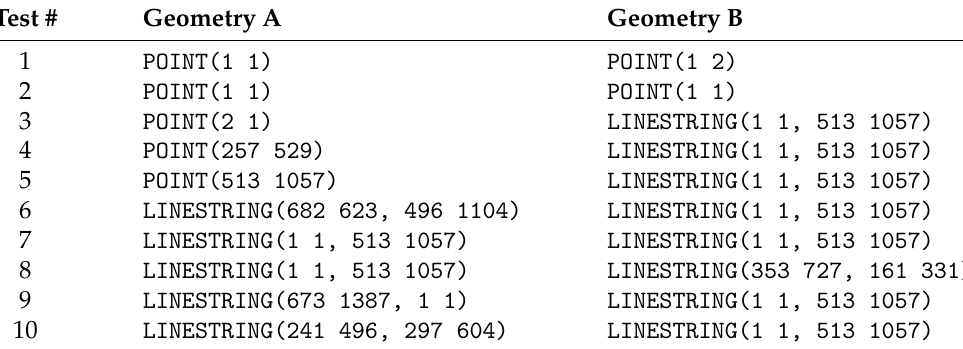
Table 6. WKT Geometries of the first 10